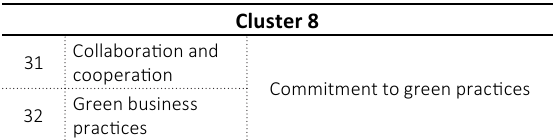
Table 9. Codes comprising Cluster 8